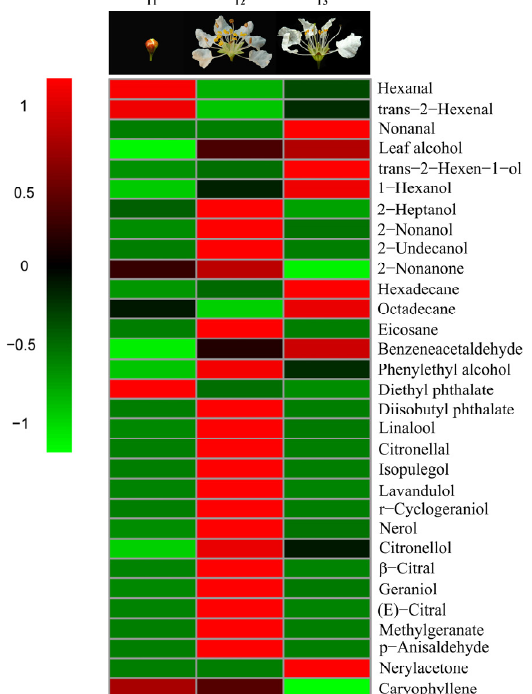
Figure 3. Heatmap with volatiles identified from L. caudata at three different flower